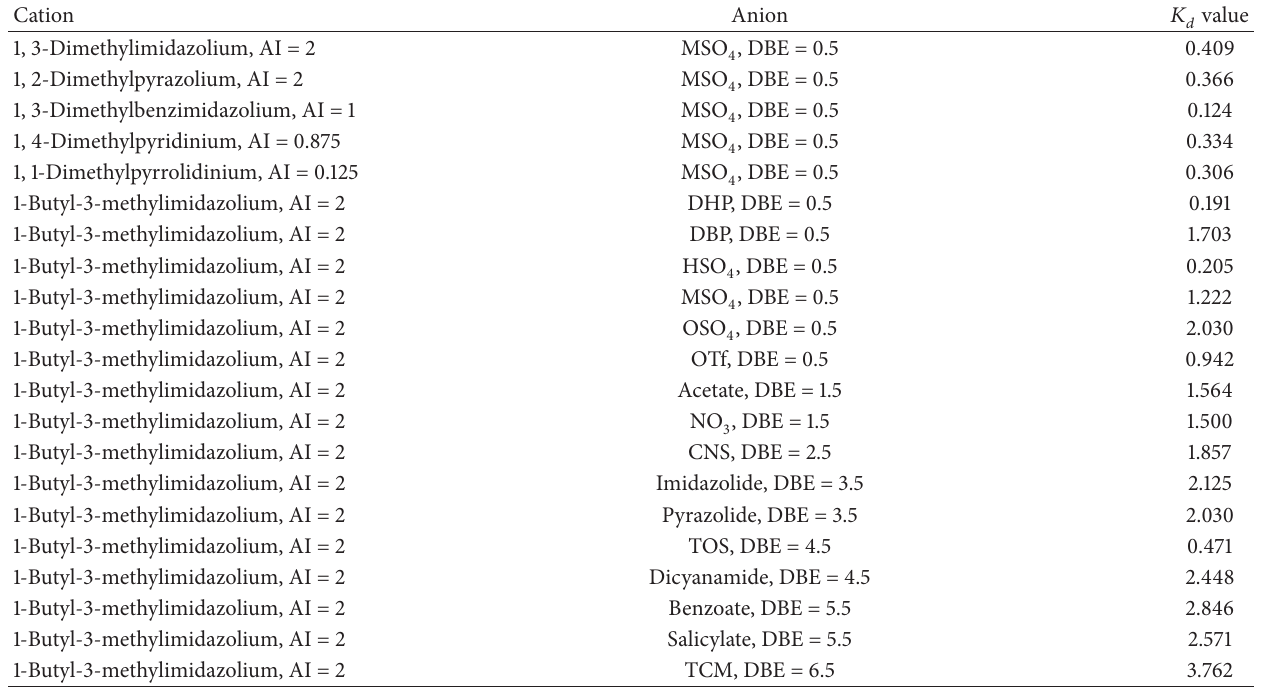
Table 2: Selected combination of cation and anion for ionic liquids with their respective calculated AI and DBE value. Cation Anion 𝐾 𝑑 value 1, 3-Dimethylimidazolium, AI =